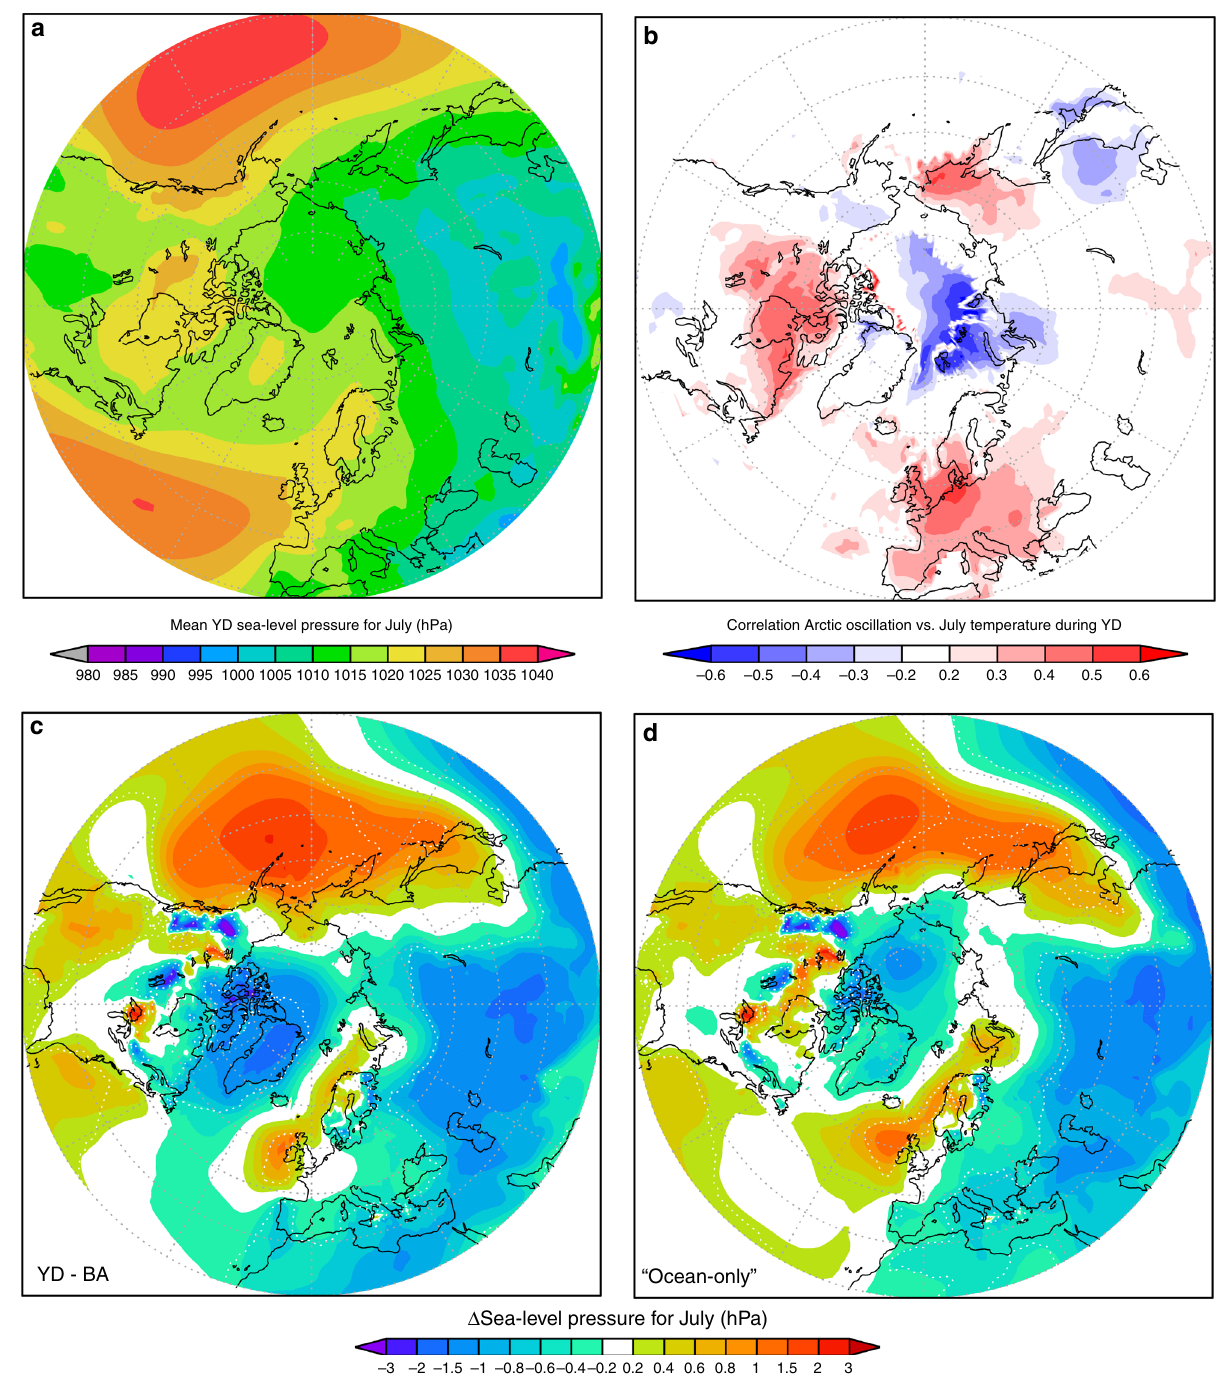
Fig. 5 Simulated atmospheric blocking and Arctic teleconnection. a Mean SLP pattern during the YD with a ridge extending from the Azores over the Fennoscandian Ice Sheet. b Correlation of mean July surface temperatures with the Arctic Oscillation (AO) (EOF1 of SLP north of 25°N). c Changes in monthly mean SLP of YD minus BA showing a strengthening of the pressure ridge over the E-Atlantic. d Same as c but without changes in radiation ( “ cold- ocean only effect ” ). Lower pressure over the Arctic during YD ( c ) resembles a positive AO which is positively correlated with warming temperatures